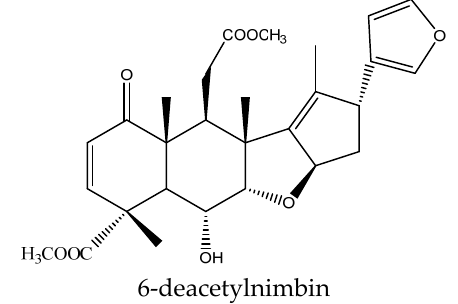
Figure 8. The structures of nimbin-class chemical: 6-deacetylnimbin.